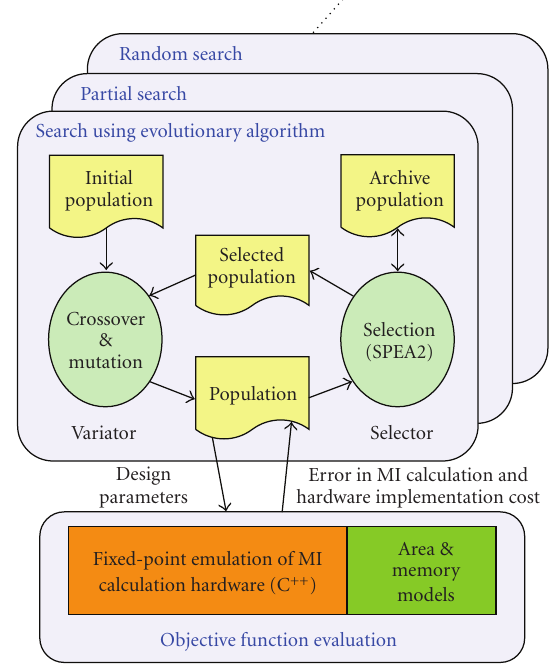
Figure 3: Framework for multiobjective optimization of FPGA- based image